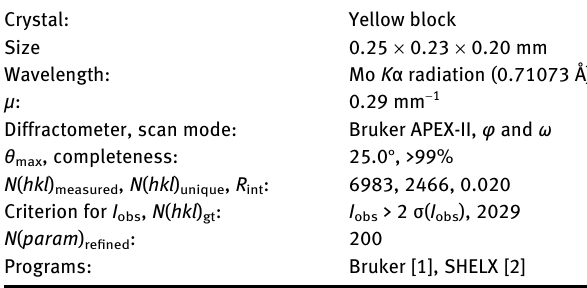
Table  : Data collection and